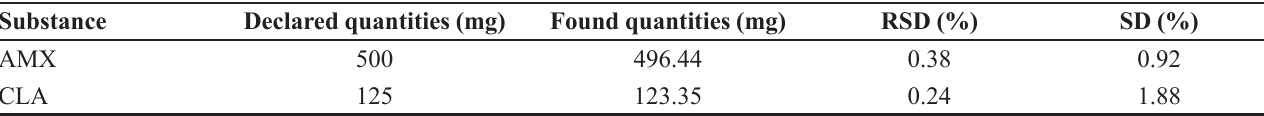
TABLE I - Analytical performance of the CZE separation Parameter